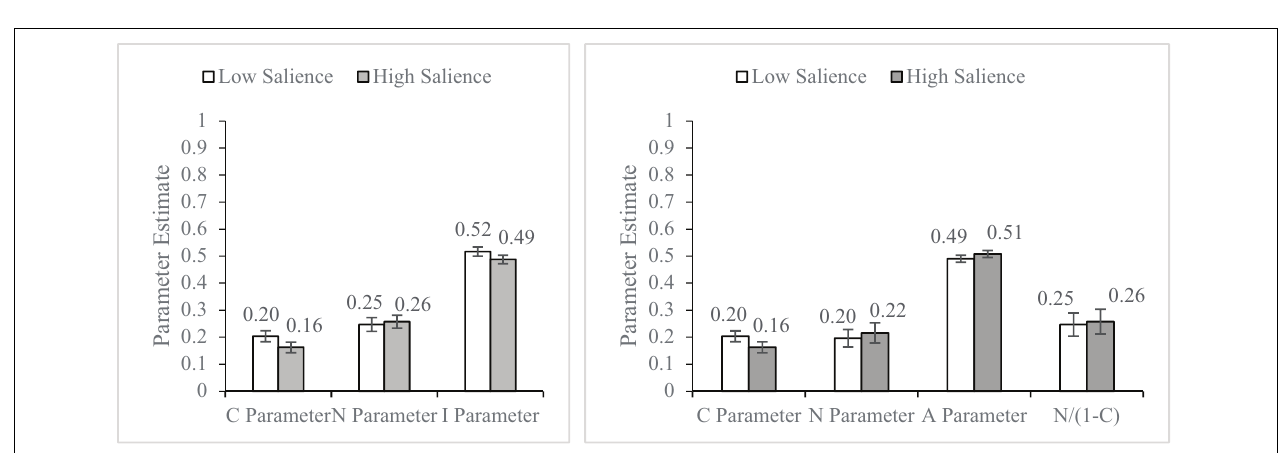
Results Parameters contrast